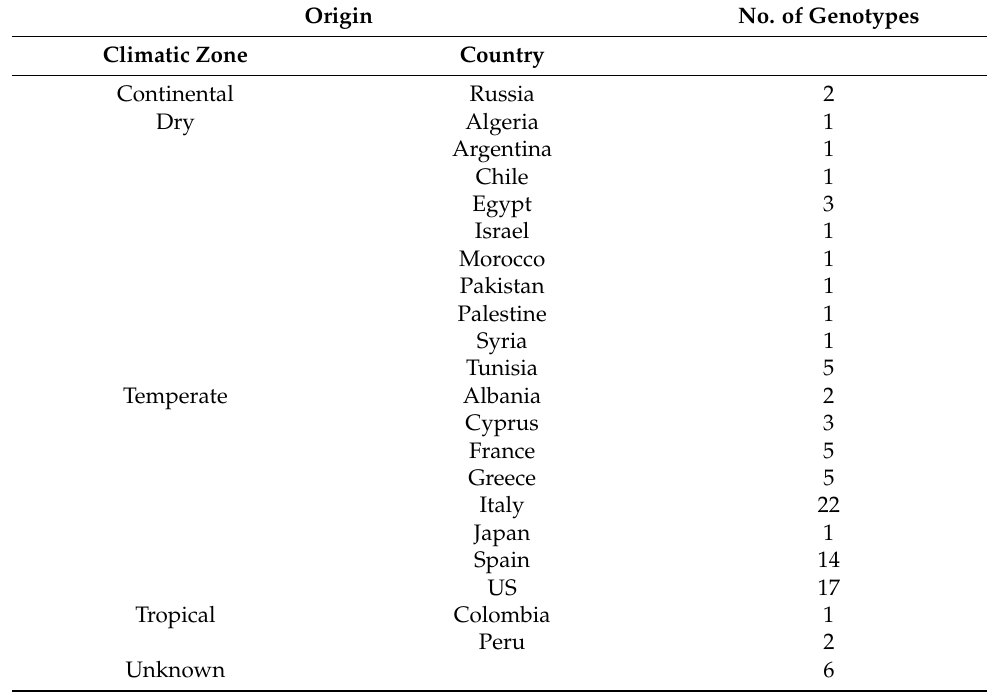
Table 1. List of the countries of origin of the 96 olive accessions with their corresponding climatic